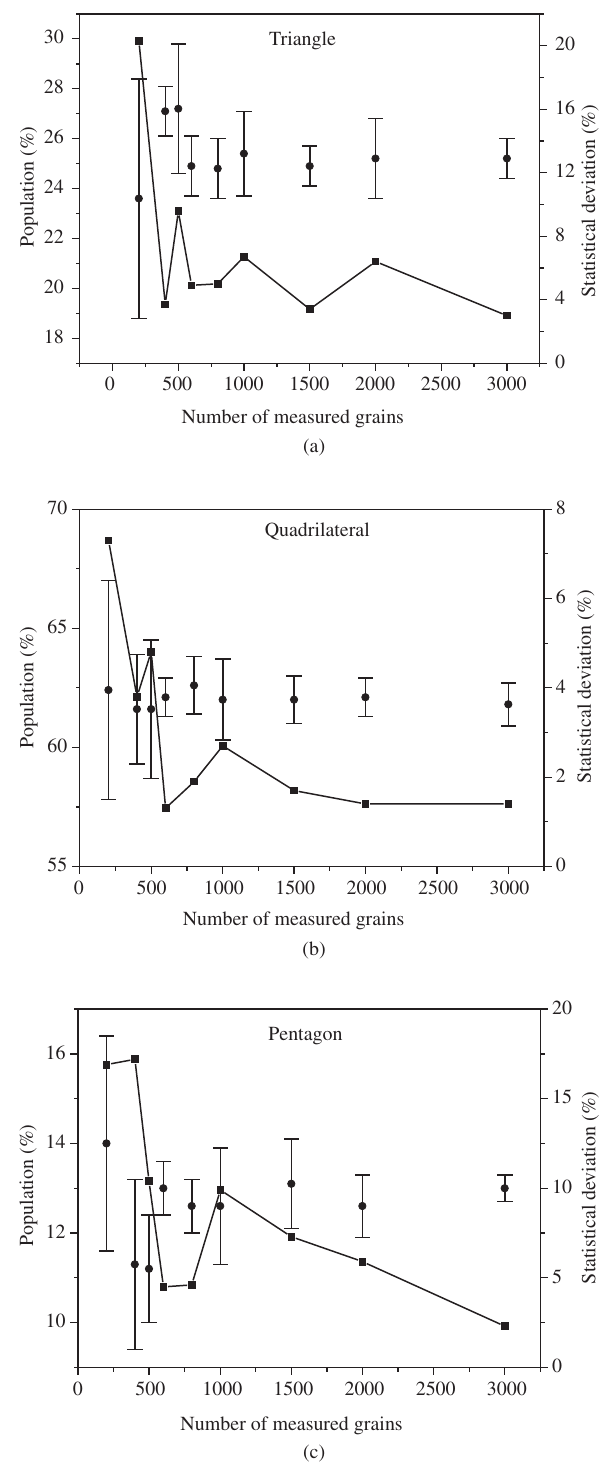
Figure 4. Mean intercept length and statistical deviation vs. the number of measured grains.